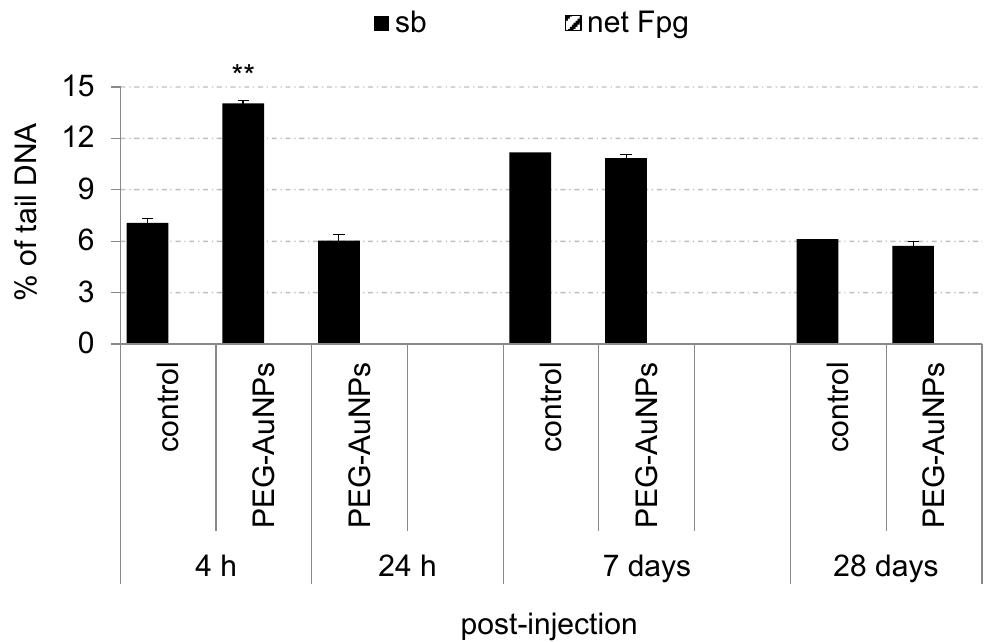
Figure 5. Genotoxic effects and oxidative damage to DNA induced by PEG-AuNPs in the primary renal cells.Data are presented as mean ± standard error of the mean (SEM). Significance: ** p < 0.01.